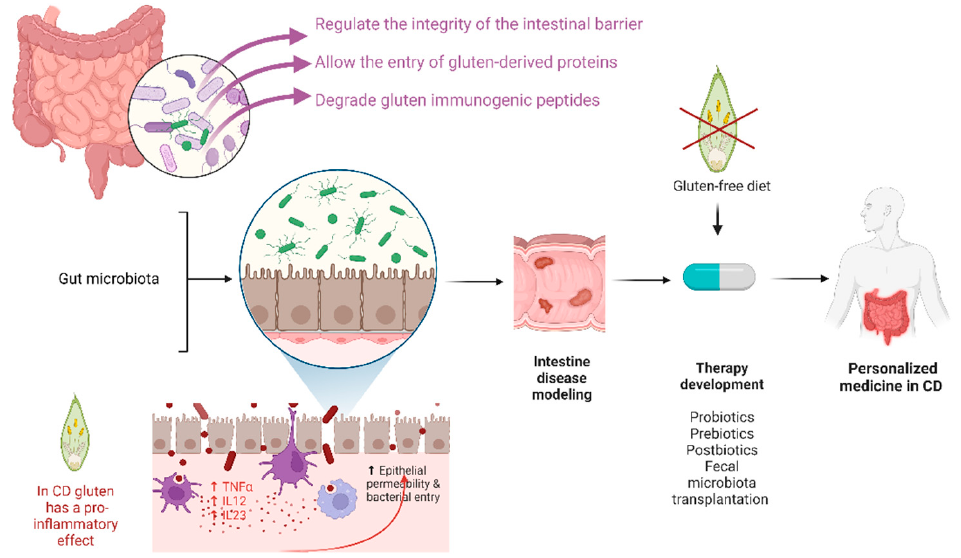
Figure 1. Biological functions of the gut microbiota with possible novel microbiome-based therapies under development as complementary strategies in celiac disease (CD).